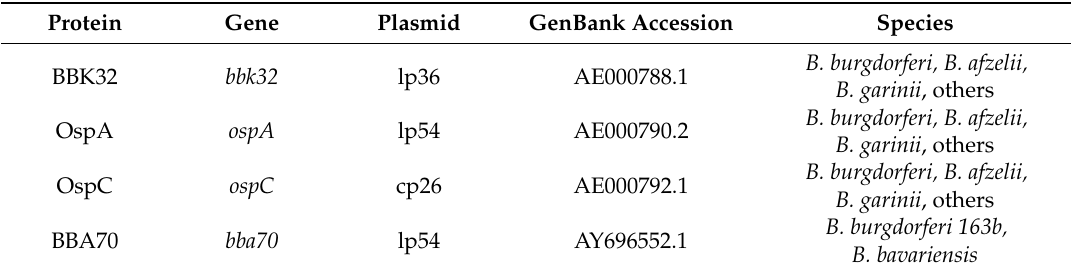
Table 1. Proteins which interfere directly with complement. GenBank accession numbers are for